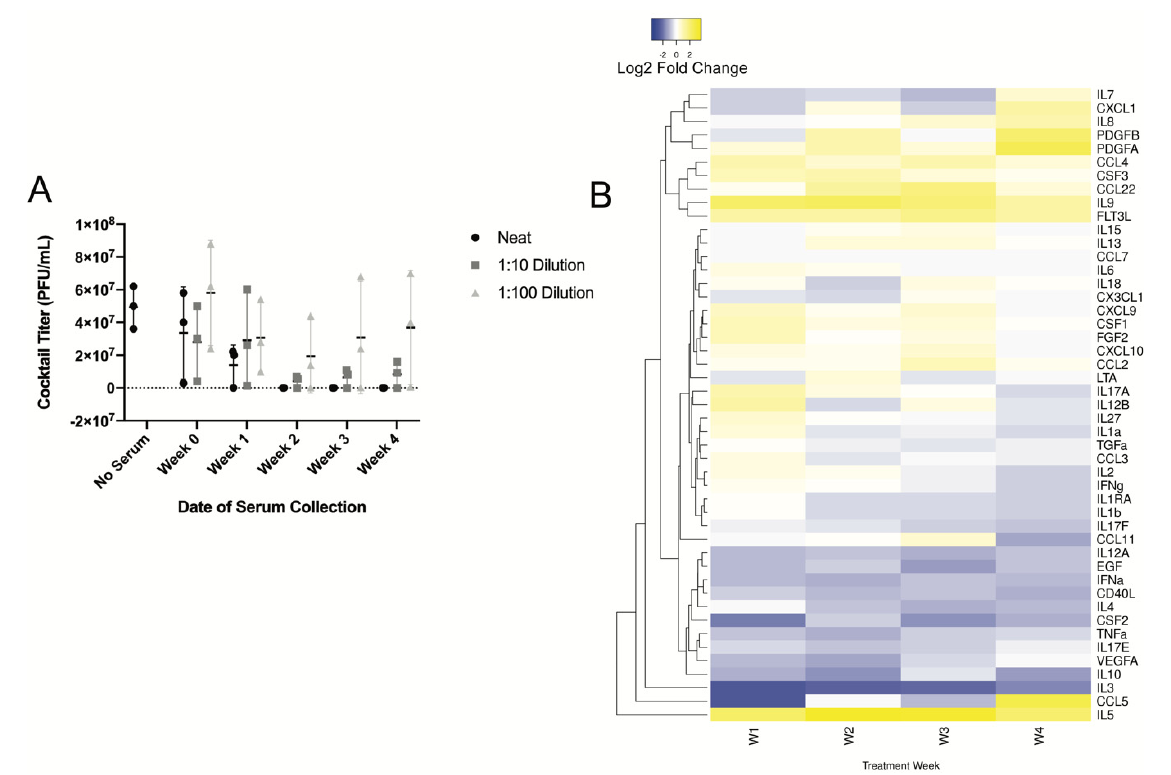
Figure 3. Patient humoral response to UCS1 Cocktail. ( A ) Equal volumes of the UCS1 cocktail mimic were mixed with phage buffer alone (No Serum), weekly patient serum samples (Neat), or dilutions in phage buffer and incubated/shaken at 37 C for 30 min. Serial dilutions from each condition were spotted onto lawns of UCS1 E. coli to determine titer. Results are reported as average +/ − SD. n = 3 technical replicates. ( B ) Luminex assays performed on weekly sera samples. Concentrations (pg/mL) of humoral markers were measured in duplicate, averaged, and standardized to pretreatment levels before being converted to Log2 values. Heatmap and hierarchal clustering were done using HeatMapper with average linkage clustering method and Euclidean distance measurements.